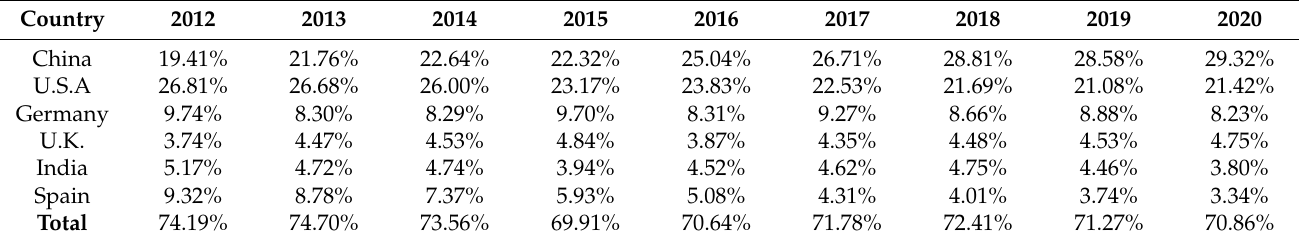
Table 2. Proportion of wind power generation in countries with highest wind farm power generation. Country